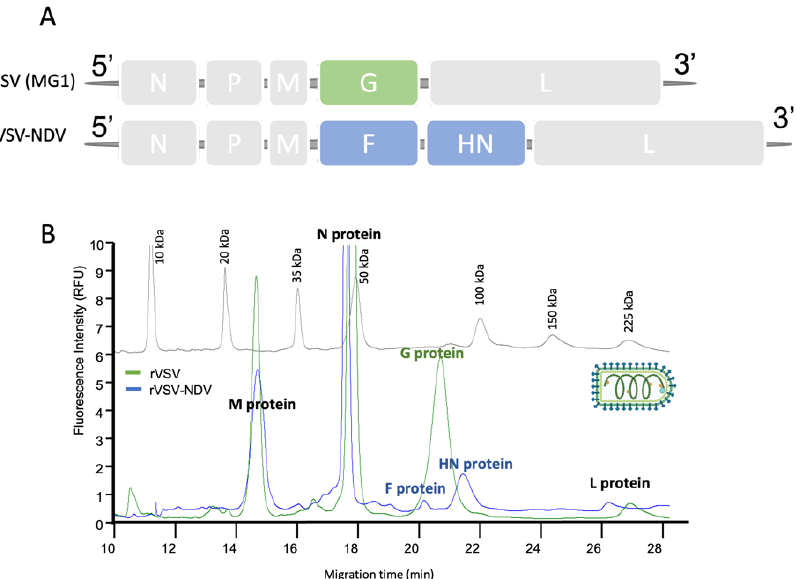
Figure 3. Characterization of chimeric virus rNDV-VSV by CE-SDS LIF. ( A ) Differences in the structural construction of rNDV-VSV and rVSV family (MG1 vector). ( B ) Overlay of the electropherograms of both viral vectors and MW marker.